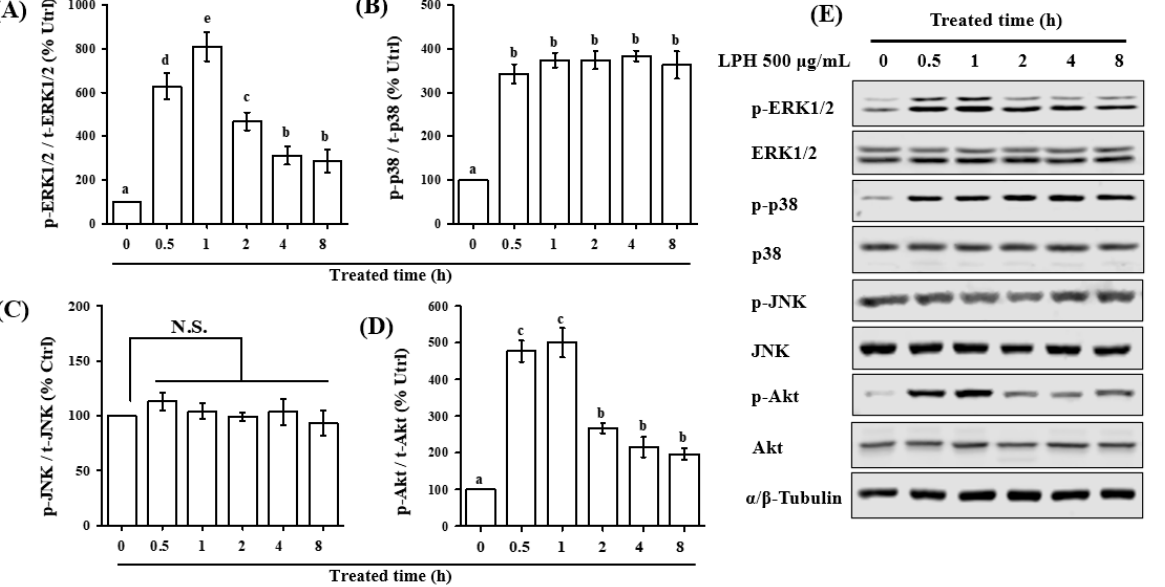
Figure 6. Effects of LPH on the activation of MAPK and Akt signaling in preosteoblast cells. MC3T3- E1 cells were seeded on 6 cm dishes until confluency and were serum starved in α -MEM for 12 h. Then, cells were treated with 500 µ g/mL of LPH for different time periods. Cell lysates were immunoblotted for the Western blotting analysis of ( A ) p-ERK1/2/ERK1/2, ( B ) p-p38/p38, ( C ) p-JNK1/2/JNK1/2, and ( D ) p-Akt/Akt. The expression of α / β -tubulin was used as the loading control, and all bands are shown in ( E ). Fluorescence intensity of the immunoblots was measured. Data are represented as the mean ± SEM, n = 3. Means without the same lowercases indicated p < 0.05. N.S. indicated p >